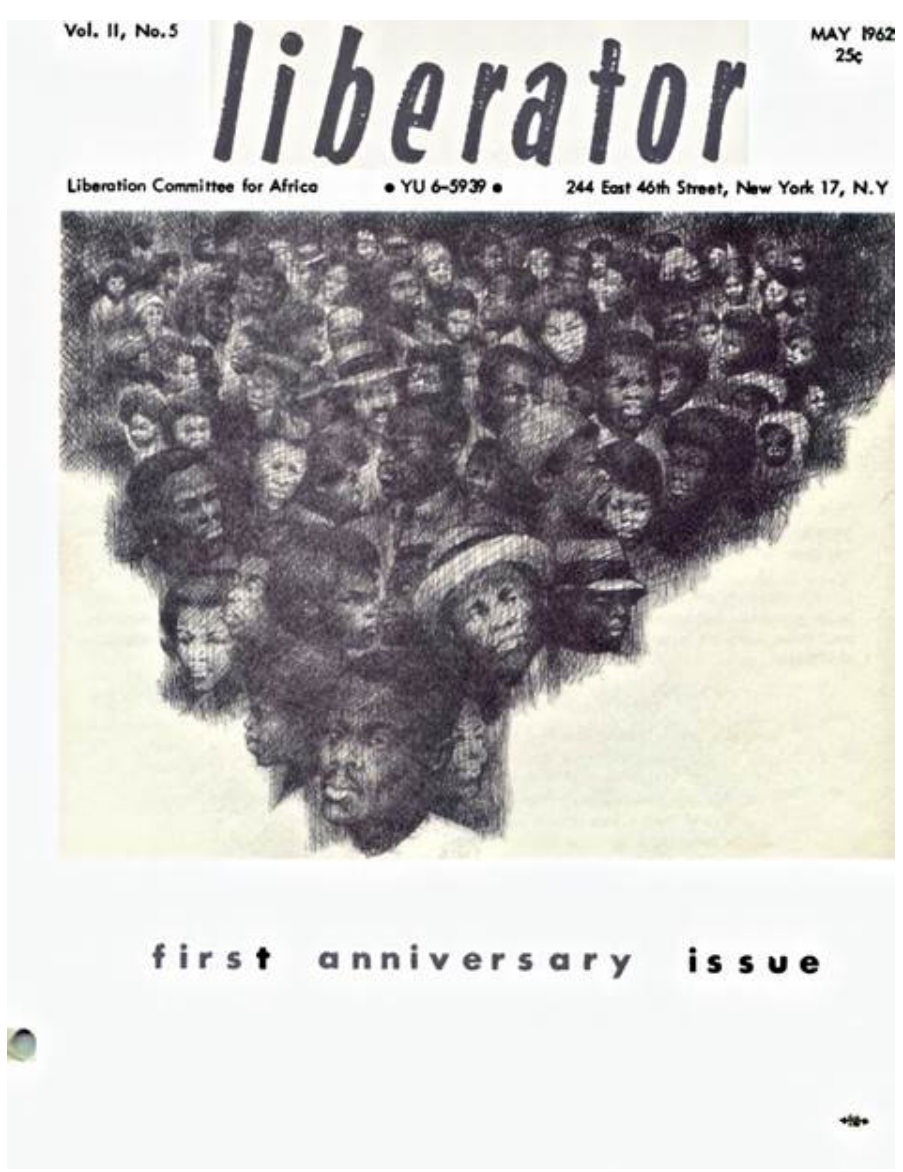
Figure 1 Cover of Liberator , May 1962. Tom